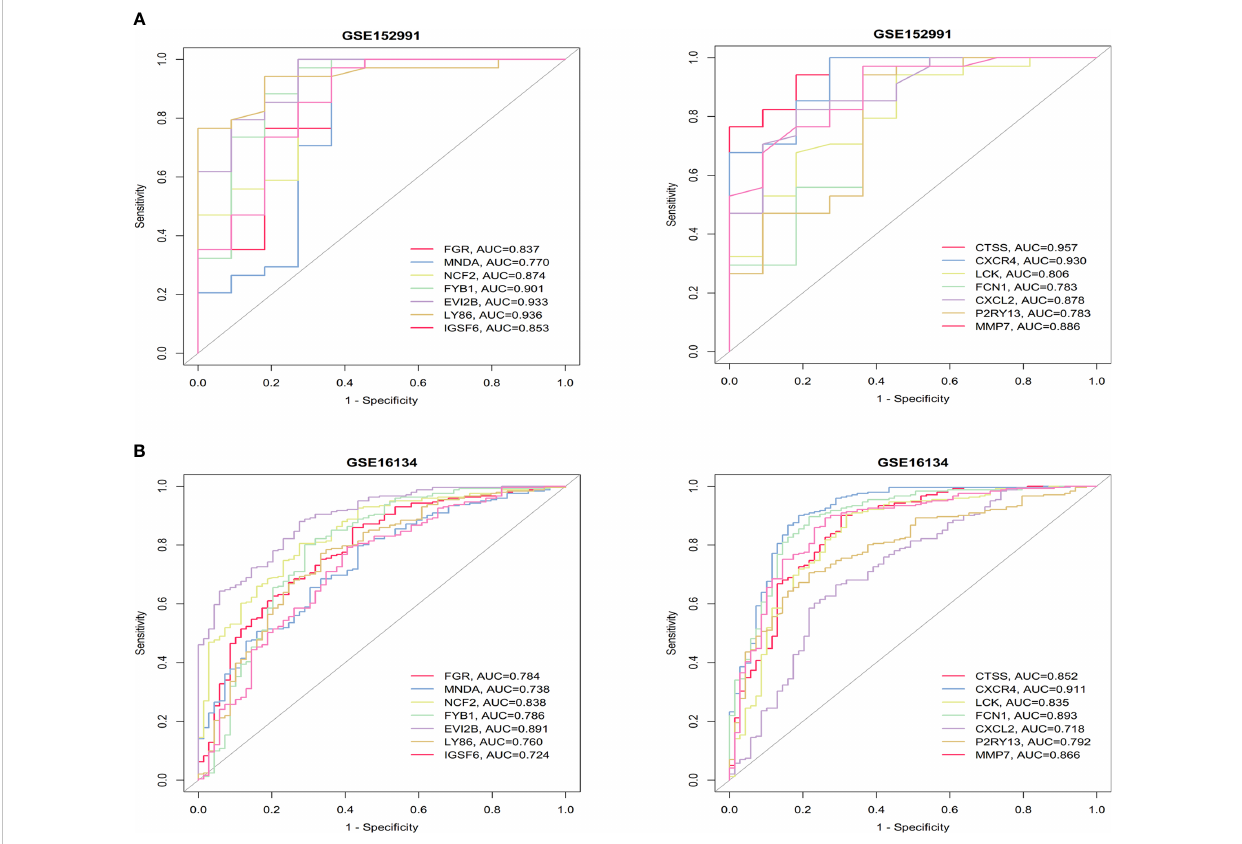
FIGURE 5 ROC curves of the 14 hub genes in obesity. (A) and periodontitis (B) . The AUC values are listed in the lower right-hand corner. ROC, receiver operating characteristic; AUC, area under the